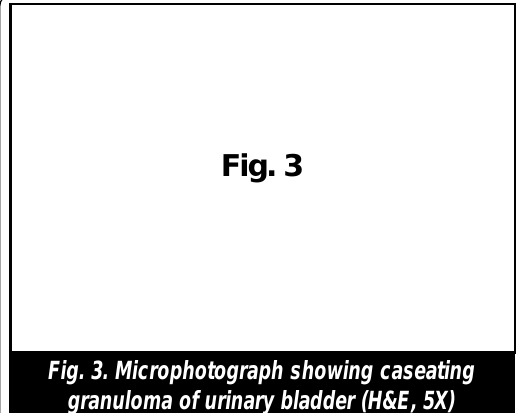
Fig. 3. Microphotograph showing caseating granuloma of urinary bladder (H&E,